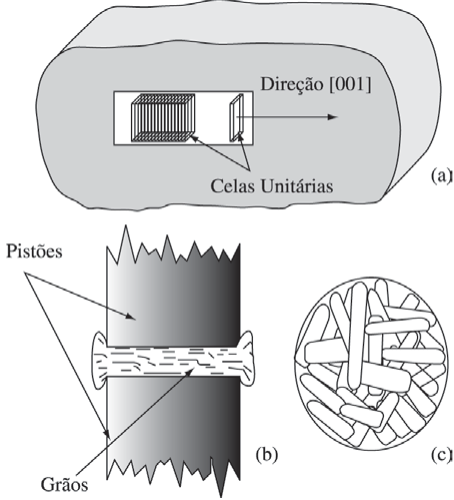
Figura 3. Padrões de difração de raios-X de cerâmicas de SBN após o primeiro (PS) e segundo estágio de sinterização (FQ (//) ou FQ( ⊥ )).